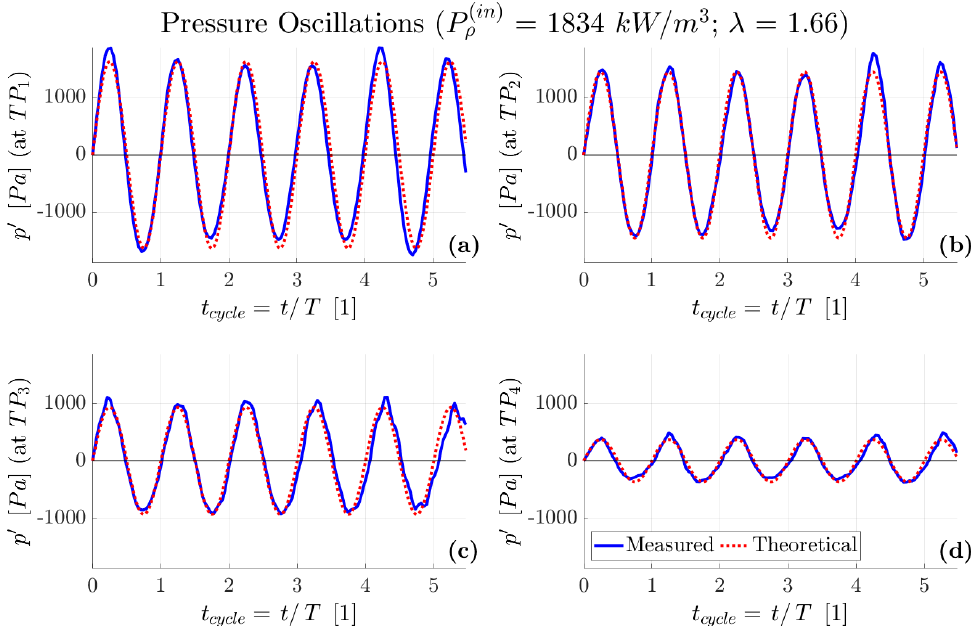
Figure 6. Oscillating pressure part for one specific operation point displayed depending on the cycle time (time normalized by the period). The solid blue curve shows the actually measured data, while the dashed red curve represents the theoretical oscillations following an ideal sine function. Each subplot displays the pressure at one location along the tailpipe: ( a ) TP 1 , ( b ) TP 2 , ( c ) TP 3 , ( d ) TP 4